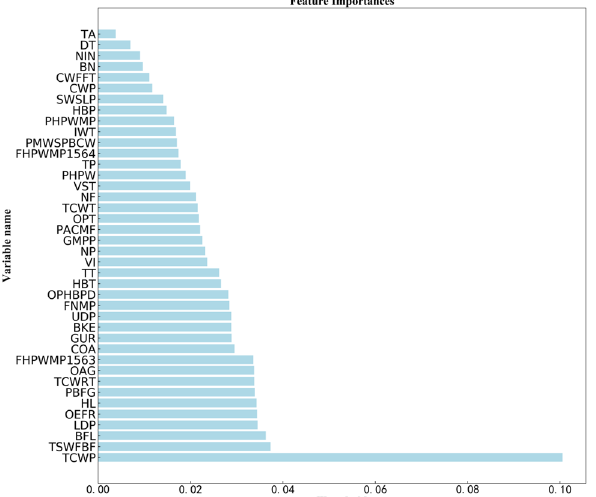
Figure 3: Model - based importance ranking.